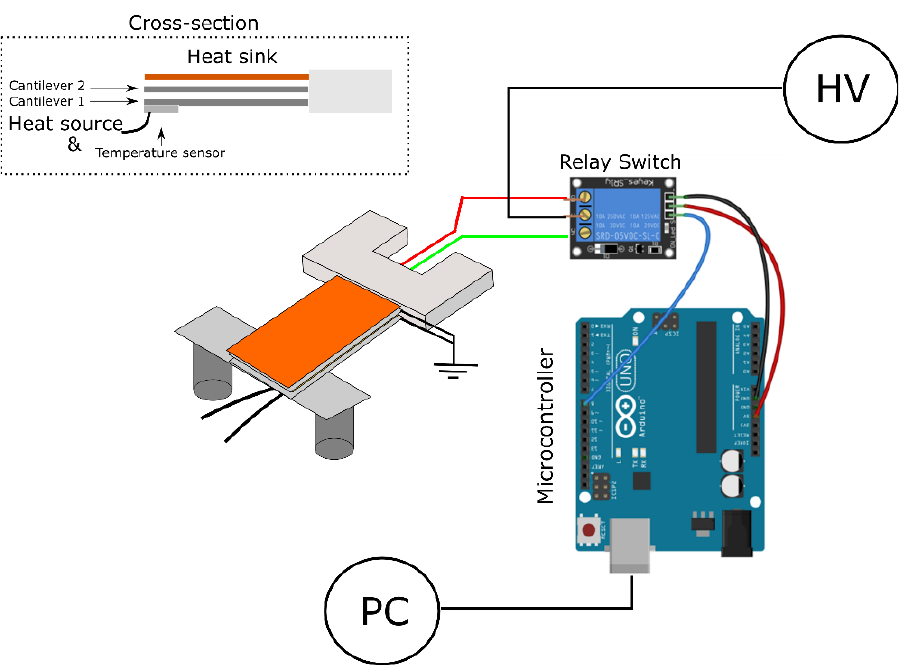
Figure 1. Experimental setup for testing the proof-of-concept device. The cantilevers were arranged in a cascade structure as shown in the inset (dashed box). From bottom to top the structure was arranged in the following order (see dashed box): heat source, cantilever 1, cantilever 2 and heat sink. The electric field applied to the two cantilevers was managed by a microcontroller circuit that controllably applied the voltage potential from the high-voltage source to the cantilevers in a repeating sequential manner. The schematic is not to scale. (Edited after Ref. [34] ) .